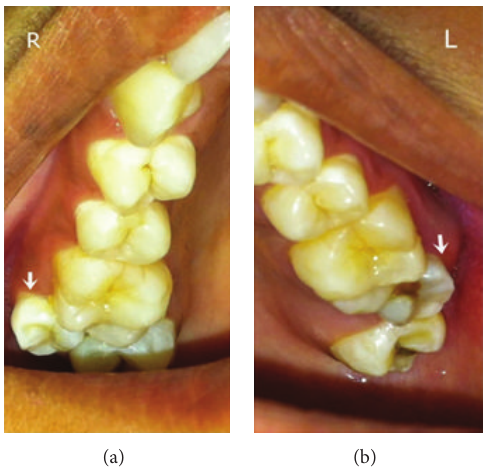
Figure 4: Showing the bilateral paramolars in case-2.